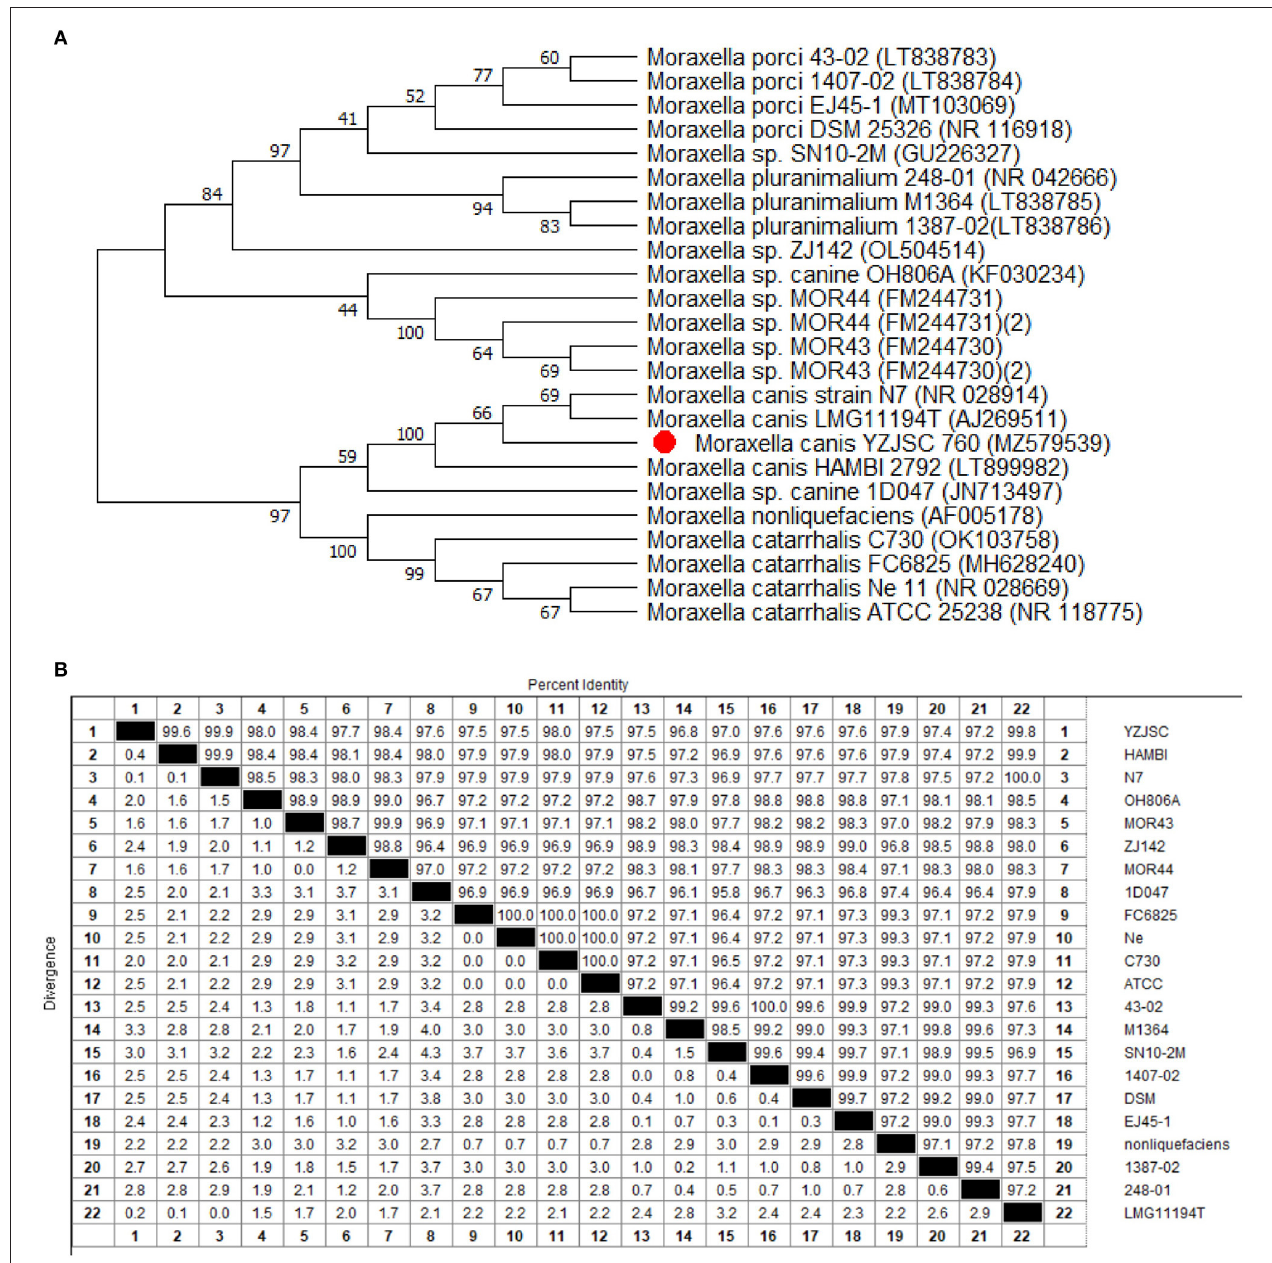
FIGURE 3 | Phylogenetic tree and homology analysis. (A) Phylogenetic tree of the genus Moraxella based on cluster of 16S rDNA gene sequences by the unweighted-pair group method with averages (UPGMA). Strains are arranged according to the distance between the corresponding sequence and the 16S rDNA gene sequence of M. canis AJ269511 and NR 028914. (B) Homology analysis showed that the YZJSC strain in this paper was high homology with HAMBI, N7, MOR43, MOR44, and